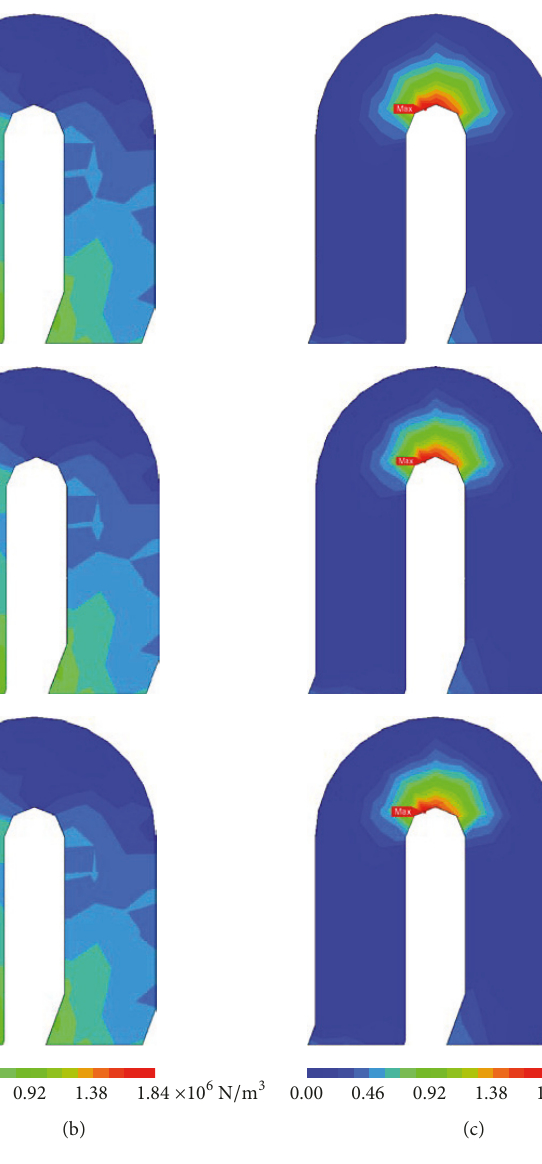
Figure 12: Electromagnetic force density magnitude distribution on the nose part at 0.039 s, when 𝑙 𝑟 = − 75 mm (bottom), 𝑙 𝑟 = 0mm (middle), and 𝑙 𝑟 = 75 mm (top). (a) Radial component. (b) Tangential component. (c) Axial component.